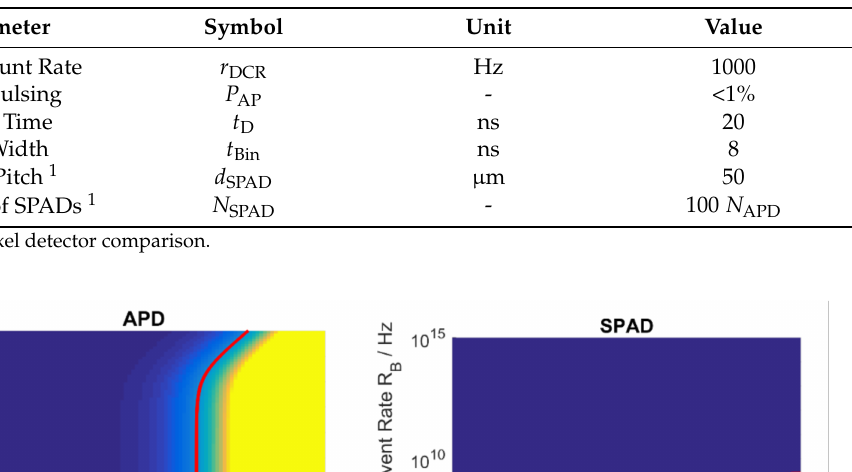
Table 1. SPAD parameters.